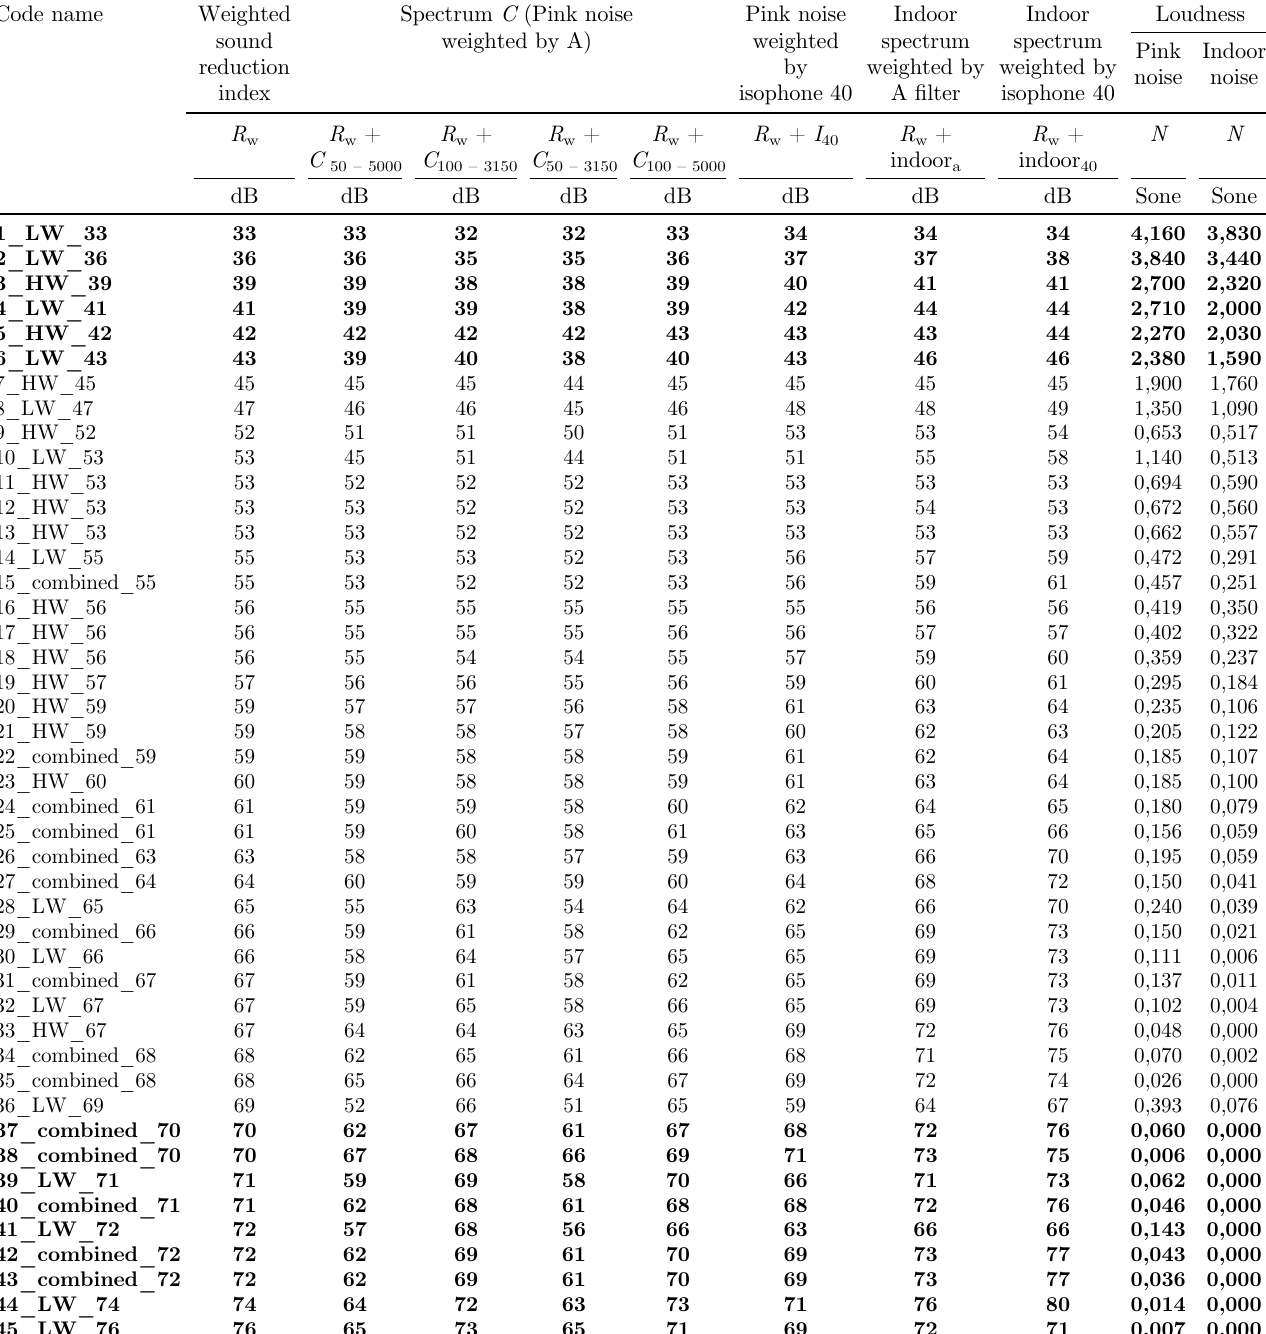
Table 2. Overview of all initially considered walls and their properties (code name of walls is composed from order_type_ _R w of analyzed walls). Acronyms LW stands for Lightweight walls, HW is for masonry walls and Combined means masonry walls with plaster boards lining system. Walls indicated in “ bold font ” had extreme properties (either having too poor insulation for separating dwelling apartments or having insulation so high that the transmitted sound was below hearing threshold) were discarded for the correlation